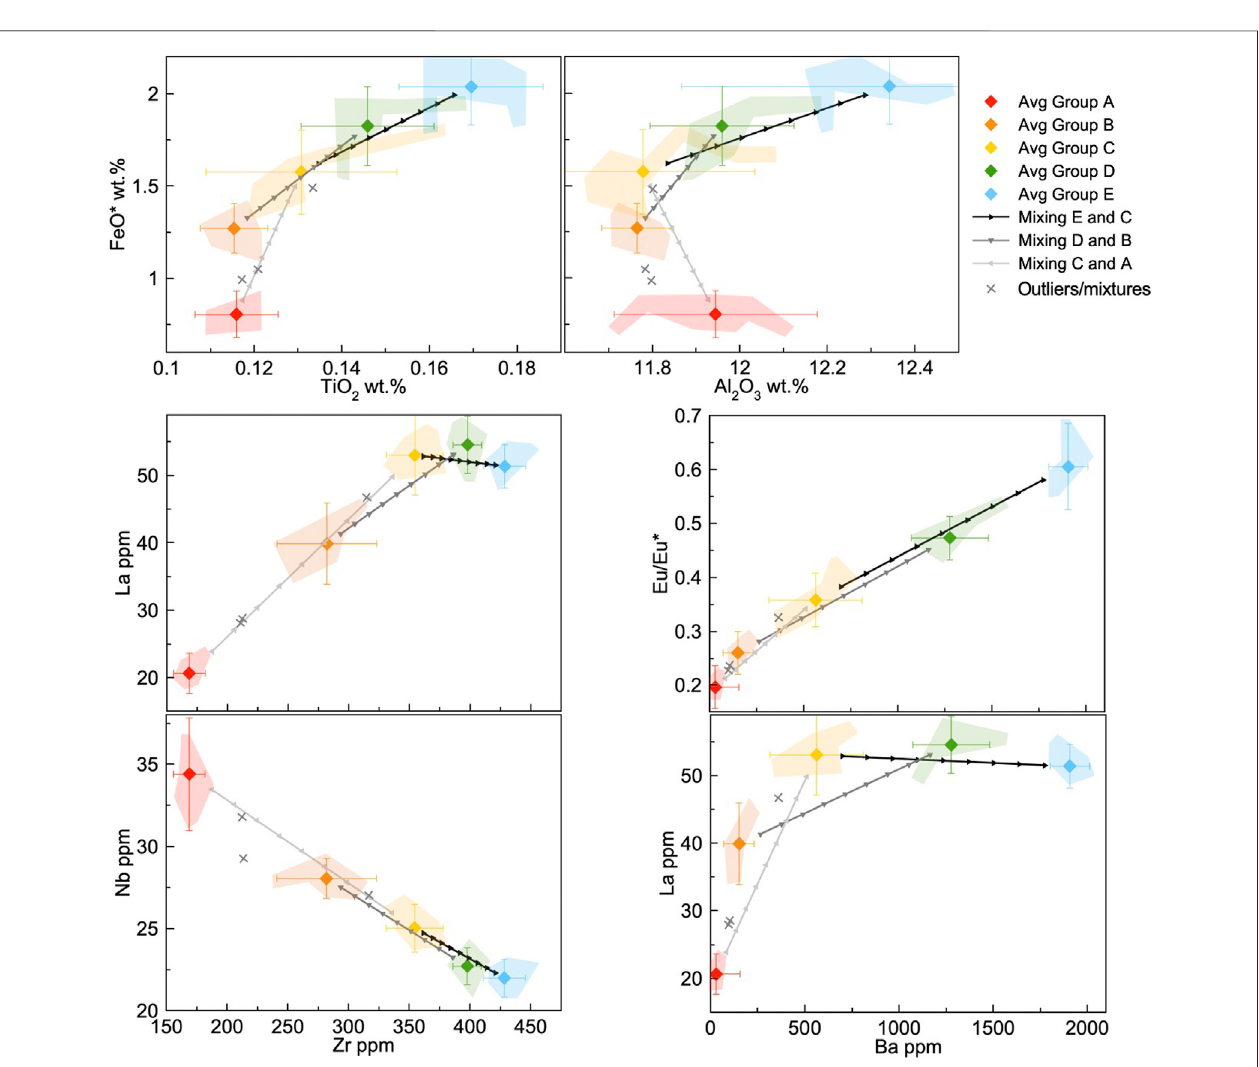
FIGURE7 | Mixing lines calculated using average Group compositionsto display how intermediate Groups arenot mixtures ofadjacent endmember Groups (e.g., Group B magma is not a mixture of Group C and A magmas). Colored polygons represent extent of compositions for each Group. The failure to produce Groups via mixing is most notable in trends observed with FeO* vs . TiO 2 , FeO* vs . Al 2 O 3 , La vs . Zr, and La vs . Ba. Error bars (2-sigma) are shown for each Group.